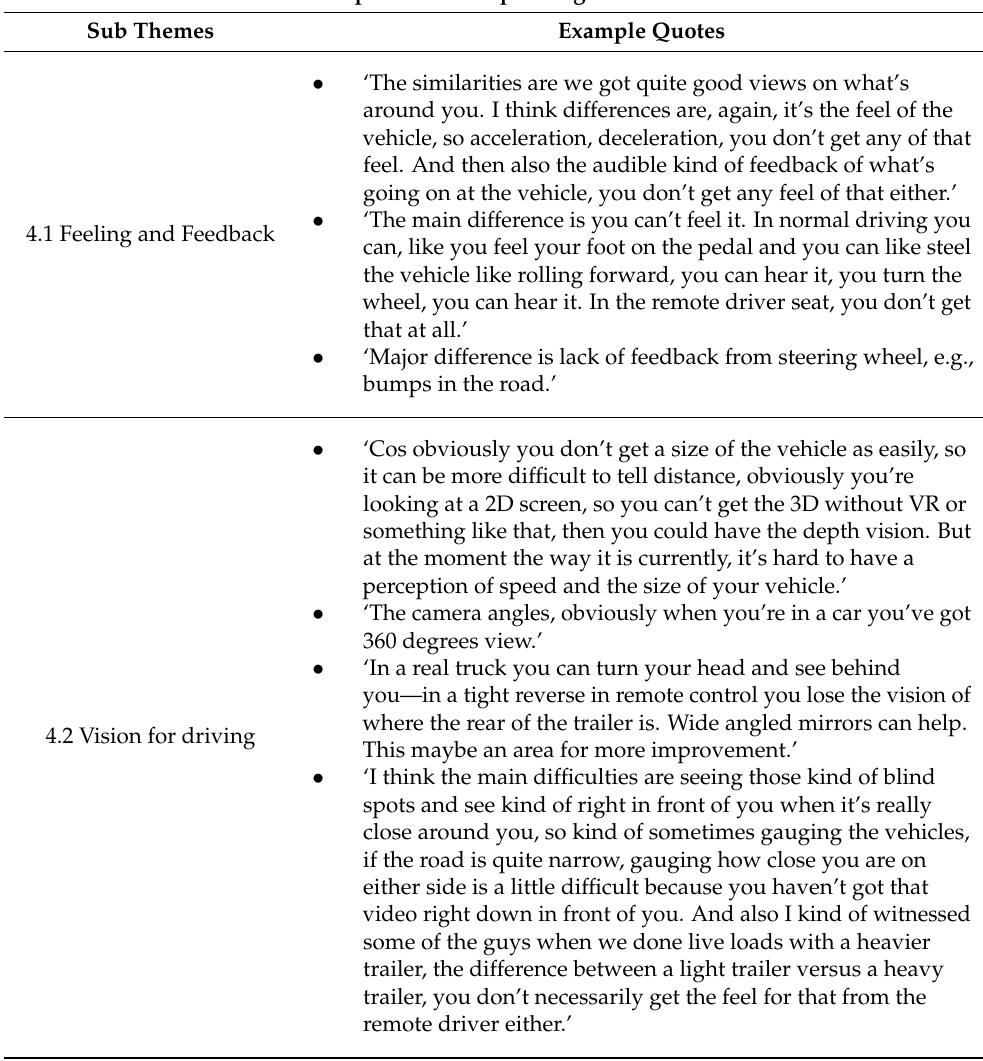
Table 4. Theme 4: Teleoperation vs. operating a vehicle